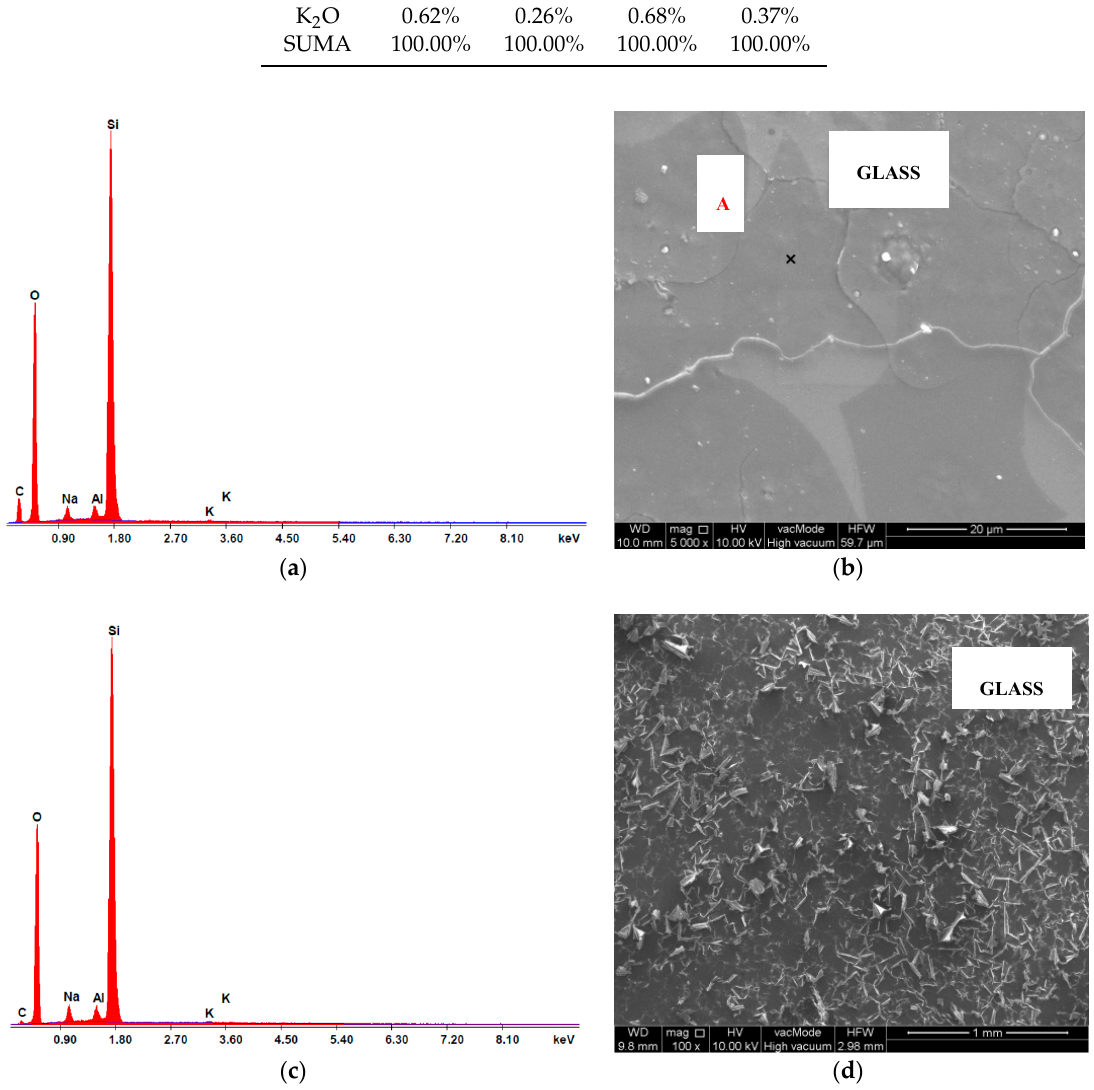
Figure 15. Analysis of oxide composition of glass cullet, 800 °C: ( a ) chemical composition spectrum of SEM-EDS, point A; ( b ) the microstructure of glass, point A; ( c ) SEM-EDS chemical composition spectrum, area; ( d ) glass microstructure, area.